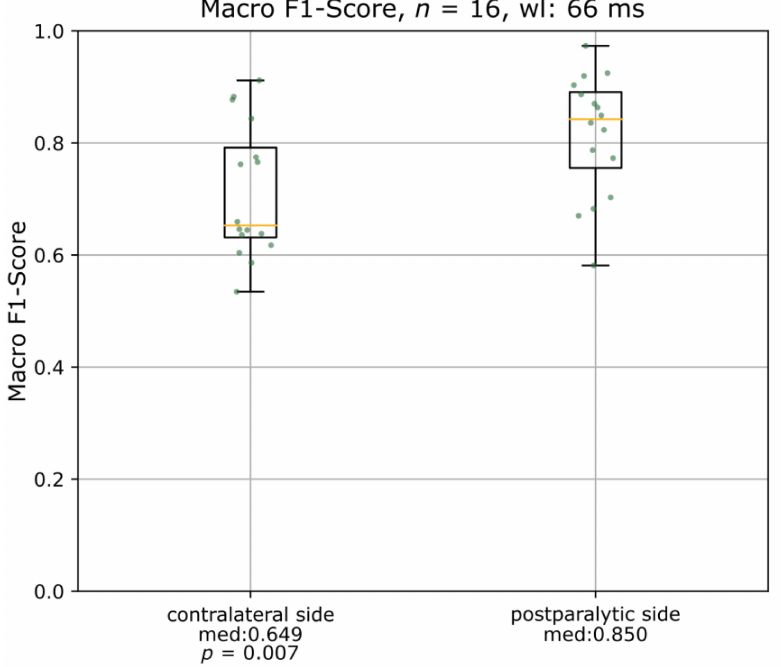
Figure 5. Boxplots of the comparison of macro F1-scores on the contralateral and the paretic side using the two best-performing muscles in each patient. wl = window length; med = median macro